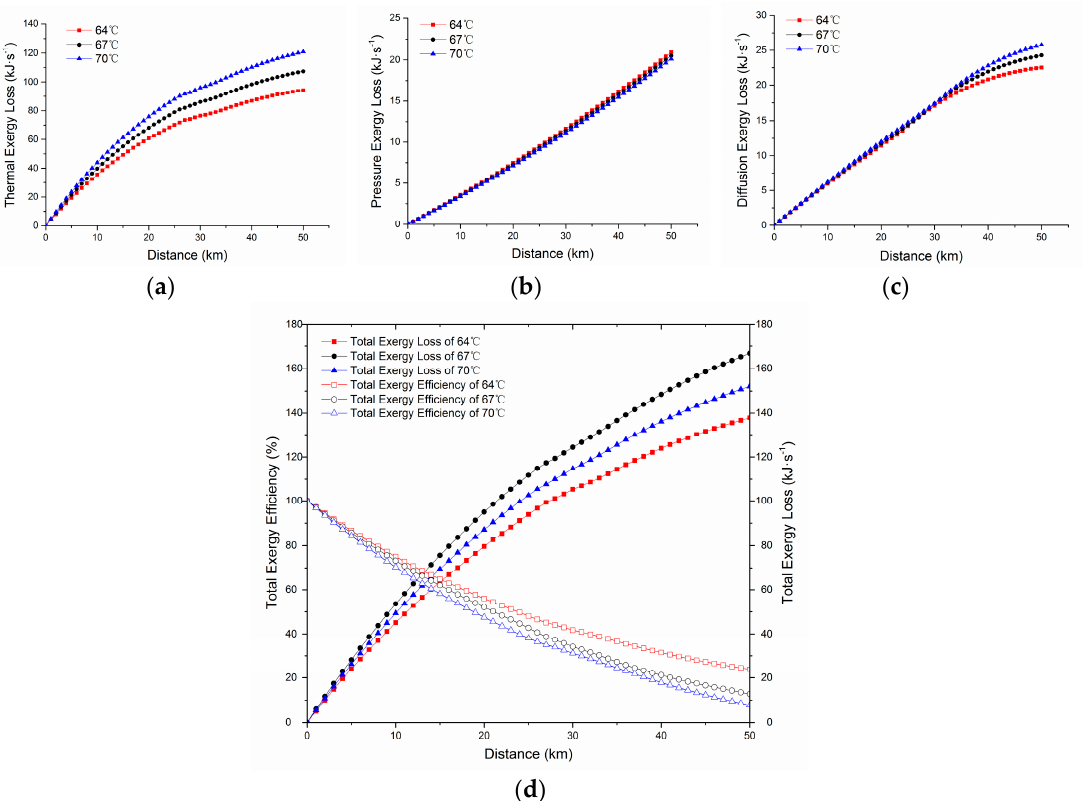
Figure 4. ( a ) The axial distribution of thermal exergy loss under different out-station temperatures; ( b ) The axial distribution of pressure exergy loss under different out-station temperatures; ( c ) The axial distribution of diffusion exergy loss under different out-station temperatures; ( d ) The axial distribution of total exergy loss/efficiency under different out-station temperatures.